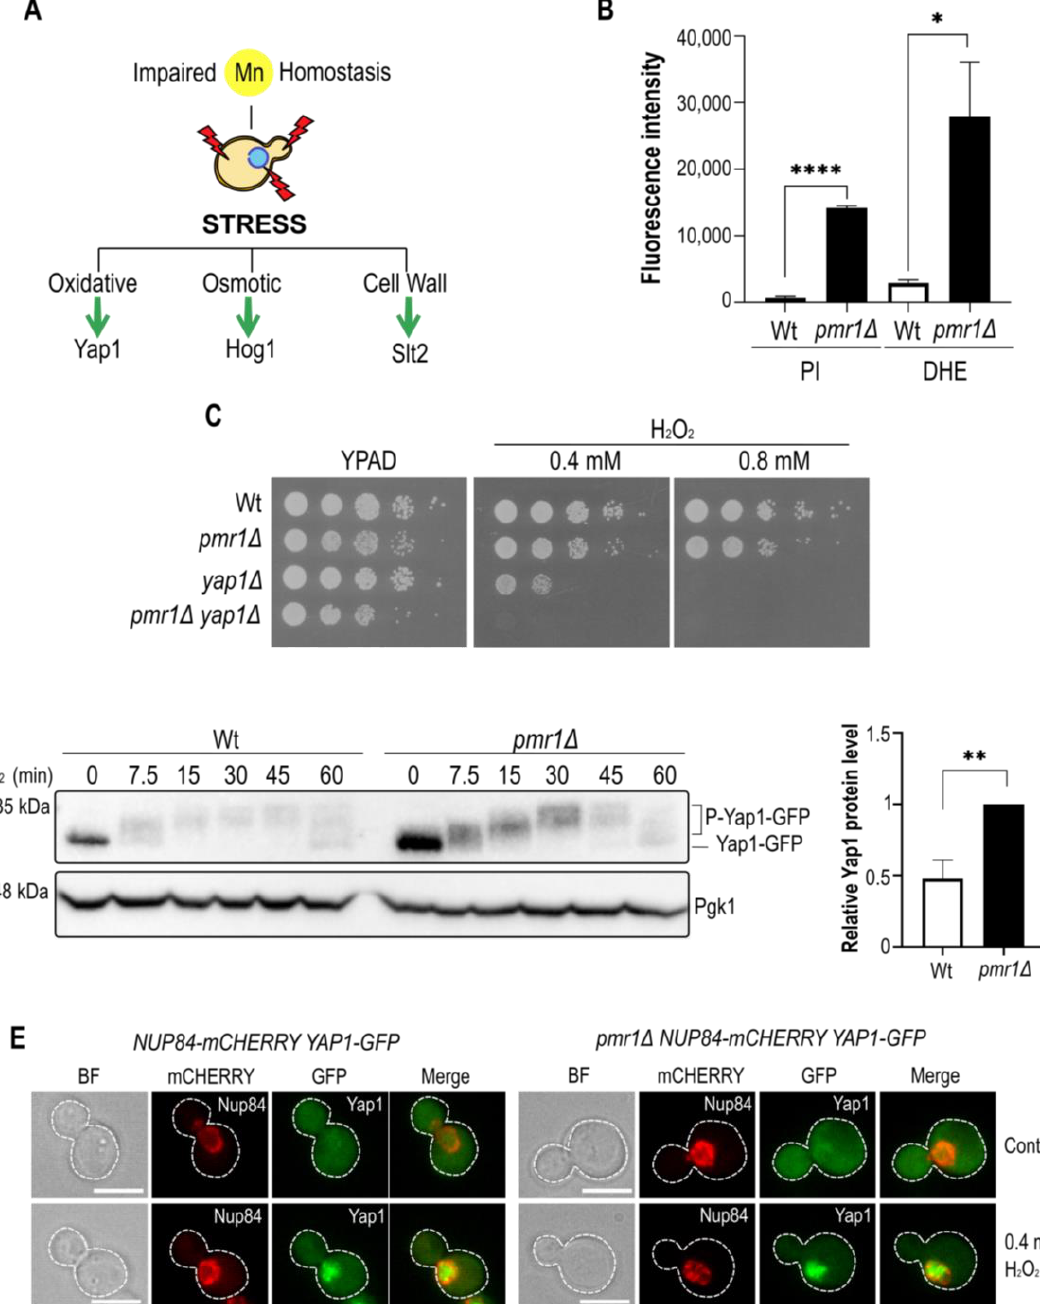
Figure 1. The manganese tolerance and oxidative stress resistance of Pmr1 depleted cells depends on Yap1. ( A ) The schematic outline of stress signaling pathways linked to oxidative stress. The effector transcription factor (Yap1) or MAPKs (Hog1, Slt2) are indicated. ( B ) Flow cytometric analysis of DHE and PI positive cells. The fluorescence intensity of positive Wt and pmr1∆ mutant cells is plotted. Standard error of the mean (SEM, with bars) and p-values are indicated ( p -value 0.05 *; 0.01 **; 0.001 ****). ( C ) Growth on peroxide-containing (H 2 O 2 ) YPAD (Yeast Ex- tract-Peptone-Adenine-Dextrose) medium. 10-fold dilutions of exponentially growing cells are shown. Strains and H 2 O 2 concentrations are indicated. ( D ) Immunoblot of Yap1-GFP modifications after H 2 O 2 addition in Wt and pmr1∆ mutants using an anti-GFP antibody. H 2 O 2 concentration and incubation times (min) prior to protein isolation are indicated. Pgk1 (3-phosphoglycerate kinase 1) protein levels, probed with anti-Pgk1 antibodies, served as a loading control. Quantification of relative Yap1-GFP levels in untreated Wt and pmr1∆ cells (right panel). Standard deviation (SD, with bars) and p-value are indicated. ( E ) Analysis of Yap1-GFP localization by fluorescence mi- croscopy. Cells were analyzed before (control) and after 7.5 min treatment with 0.4 mM H 2 O 2 . Nup84-mCherry was used as a nuclear marker. Scale bar represents 5 µm.